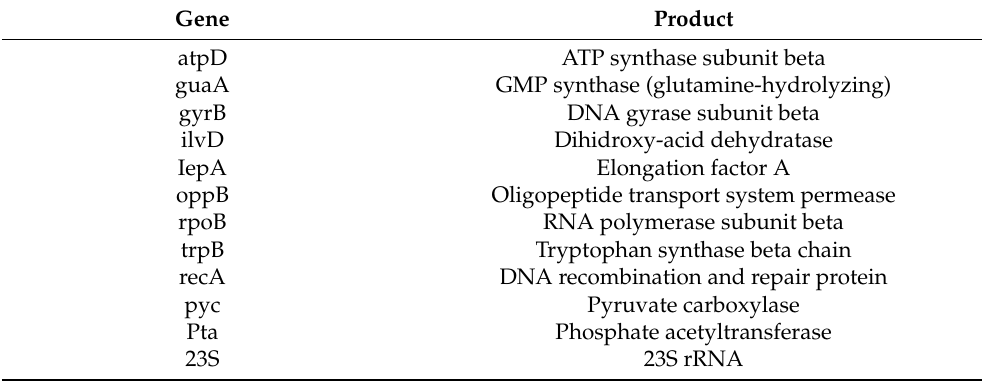
Table 1. Genes used in MLSA of nonproteolytic C. botulinum strains. Reprinted/adapted with permission from Ref. [39]. Copyright 2015, copyright Weedmark et al. Gene Product atpD ATP synthase subunit beta guaA GMP synthase (glutamine-hydrolyzing) gyrB DNA gyrase subunit beta ilvD Dihidroxy-acid dehydratase IepA Elongation factor A oppB Oligopeptide transport system permease rpoB trpB recA DNA recombination and repair protein pyc Pta Phosphate acetyltransferase 23S 23S